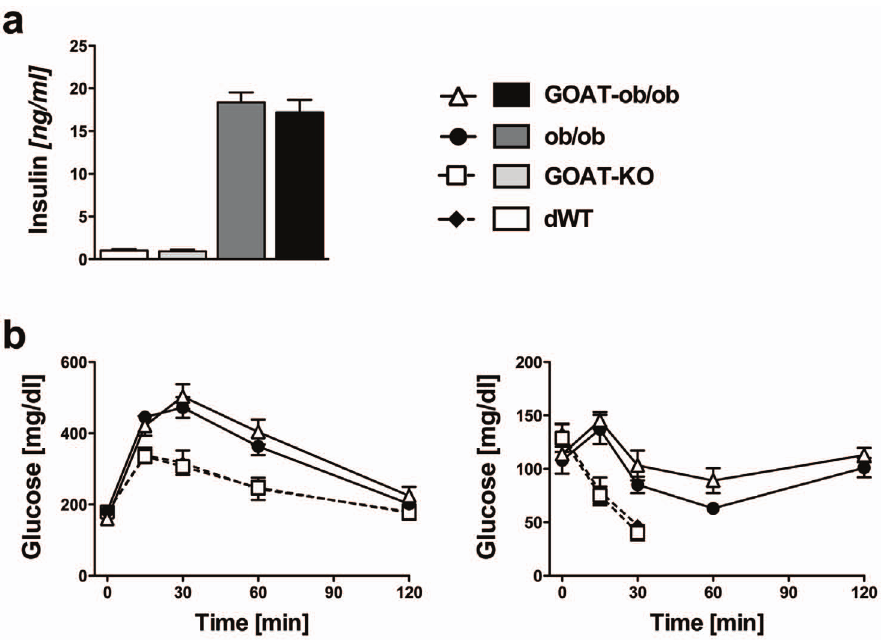
Figure 4. GOAT ablation does not improve glucose homeostasis in mice on a leptin-deficient ob/ob background. a) Fasting insulin levels in 4-month-old chow-fed WT, GOAT-KO, ob/ob mutant and GOAT-ob/ob mice. b) Glucose tolerance tests (b left panel; 1 g glucose/kg body weight) in chow-fed mice revealed no improvement in glucose tolerance by GOAT ablation. Insulin tolerance tests in mice fed with MCT diet (b right panel; 0.75 U insulin/kg body weight) suggested severe insulin resistance in both GOAT-ob/ob and ob/ob mutant mice, and a normal insulin sensitivity in GOAT-KO and dWT mice. (n=6–10).